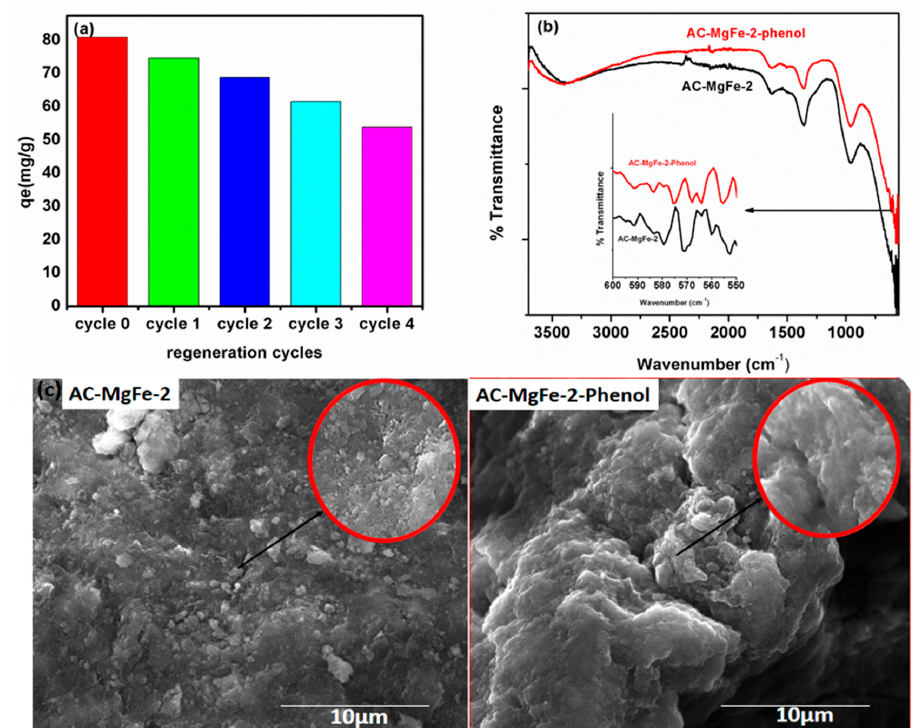
Figure 8. ( a ) Reusability performance of AC–MgFe after regeneration ( b ) FTIR and ( c ) SEM images of AC–MgFe-2 composite before and after phenol removal (red circle indicate magnified point image).